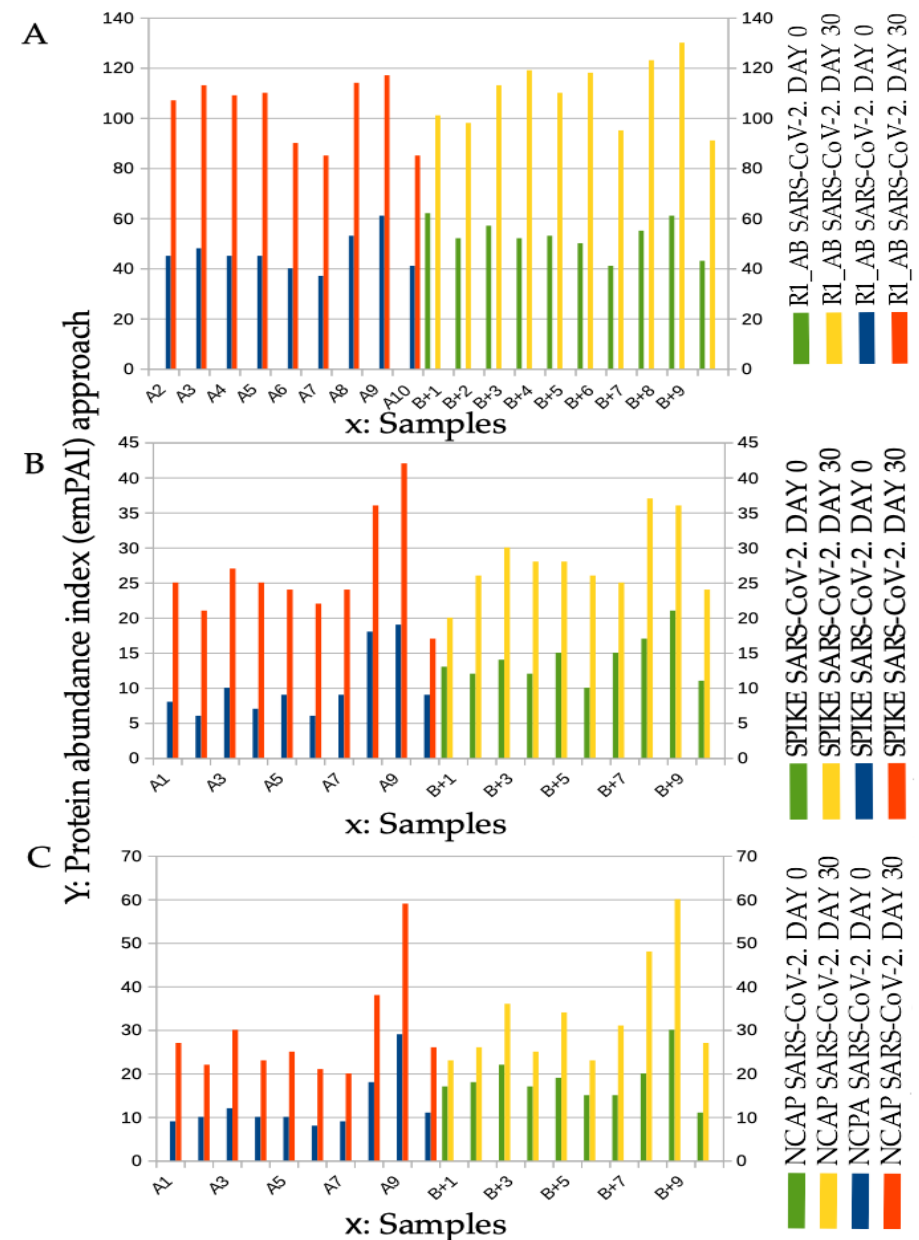
Figure 3. Increase of SARS-CoV-2 protein abundance at spectral counting quantification at day 0 and day 30 in the samples called A and in the samples called B+ (+ Contaminated with A). Panel A : Protein R1_AB SARS-CoV-2 spectral counting quantification. The spectral counting confirms the growth of the abundance of the peptides. “Replicase polyprotein 1AB (P0DTD1, UniProt ) is a multi- functional protein involved in the transcription and replication of viral RNAs”. Panel B : Protein SPIKE SARS-CoV-2 spectral counting quantification). The spectral counting confirms the growth of the abundance of the peptides. “Spike protein S1 (P0DTC2 UniProt) attaches the virion to the cell membrane of the epithelium cells by interacting with host receptor.” [database UniProt]. Panel C : Protein